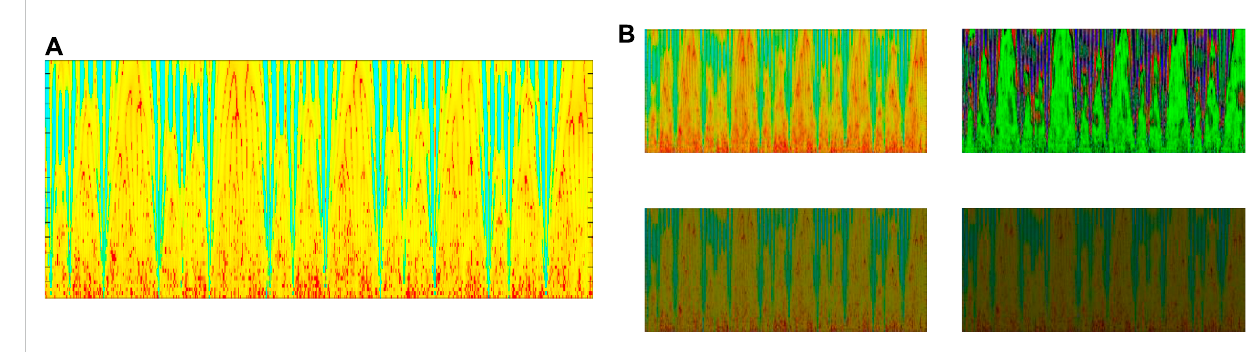
FIGURE 9 Gamma change of the image, (A) is the original image, and (B) is the image after gamma change.